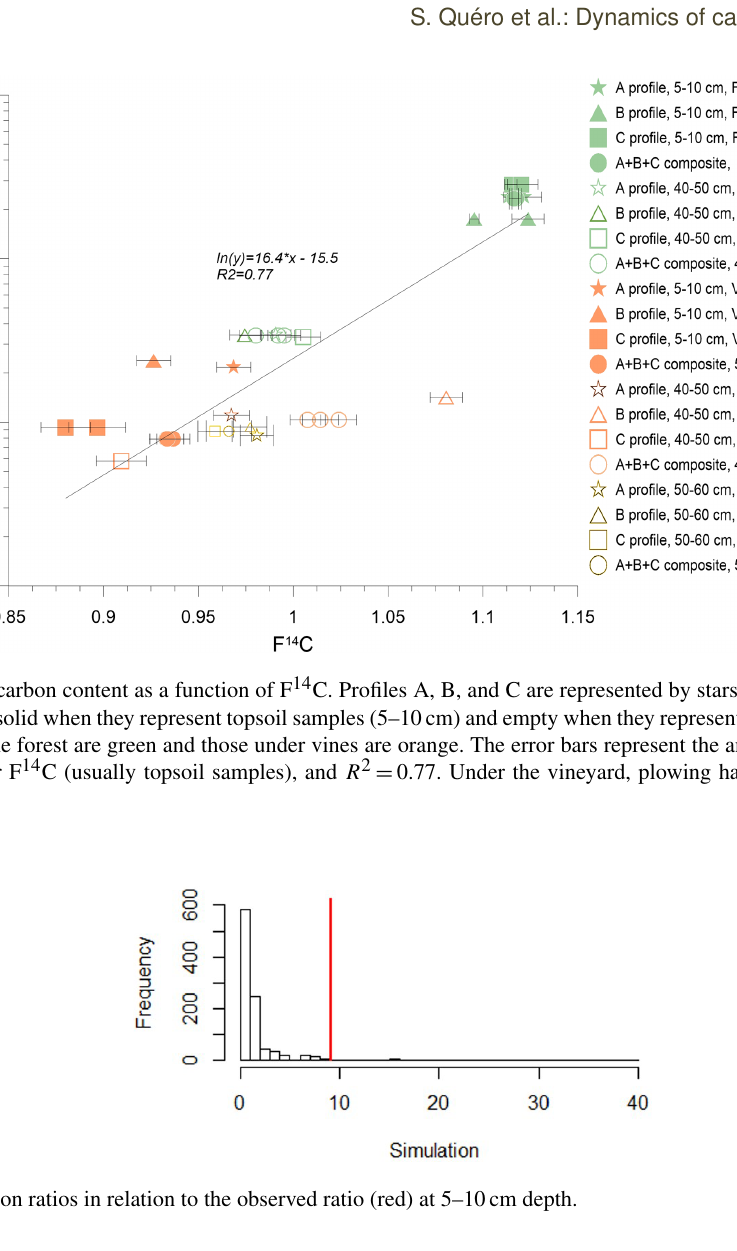
SOIL, 8, 517–539, 2022